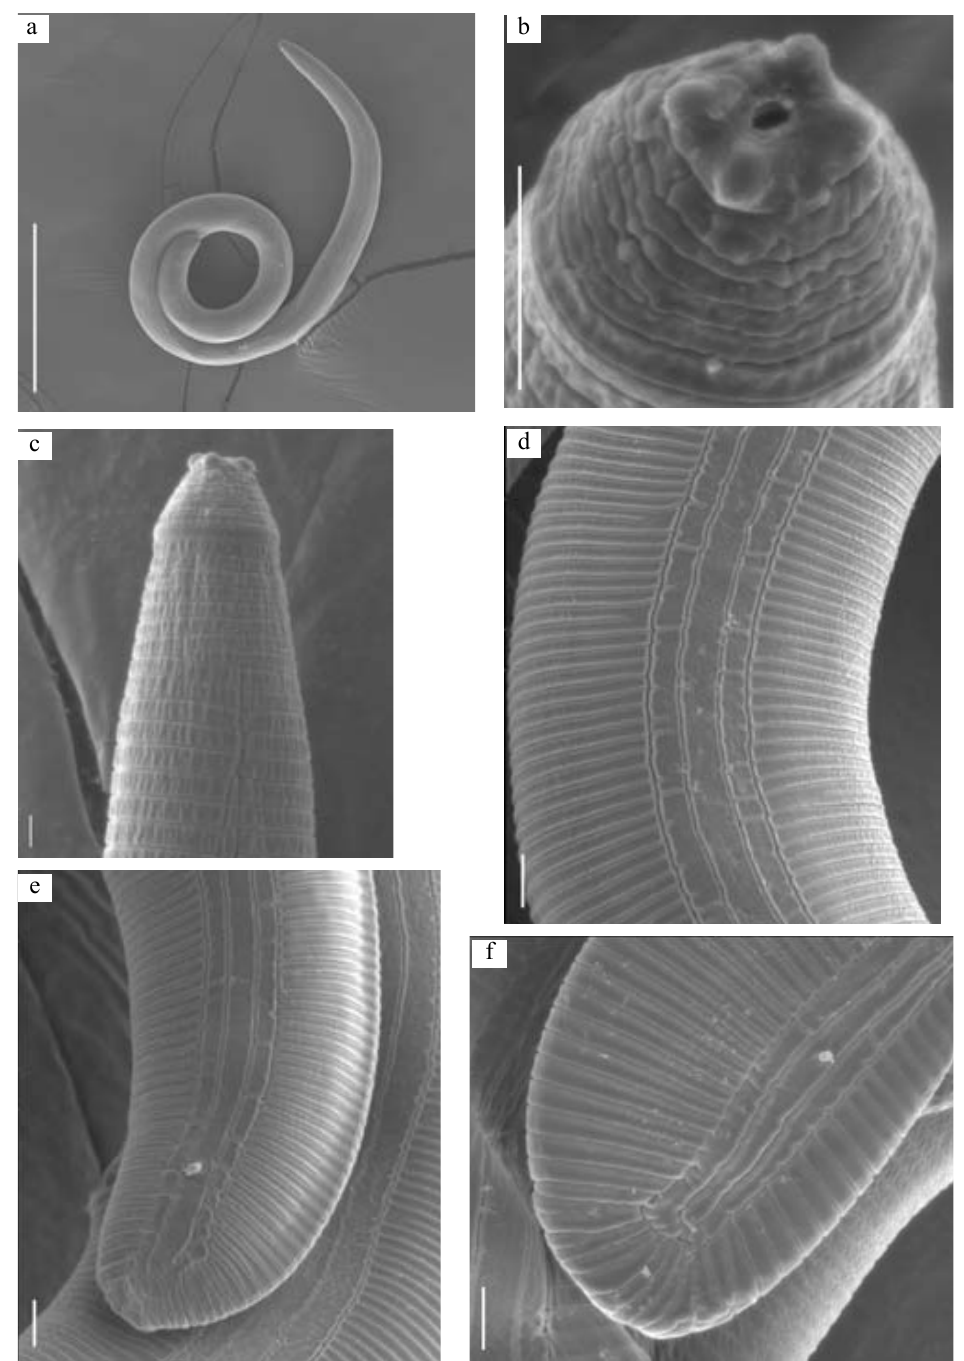
Fig. 1. Helictylenchus curatus sp. n. Female. (a) Habitus. (b) En face view, lip region. (c) Lateral view, ante- rior part of body. (d) Lateral field. (e-f) Posterior part of body. (Scale bar: a = 100 µm, b-e = 4